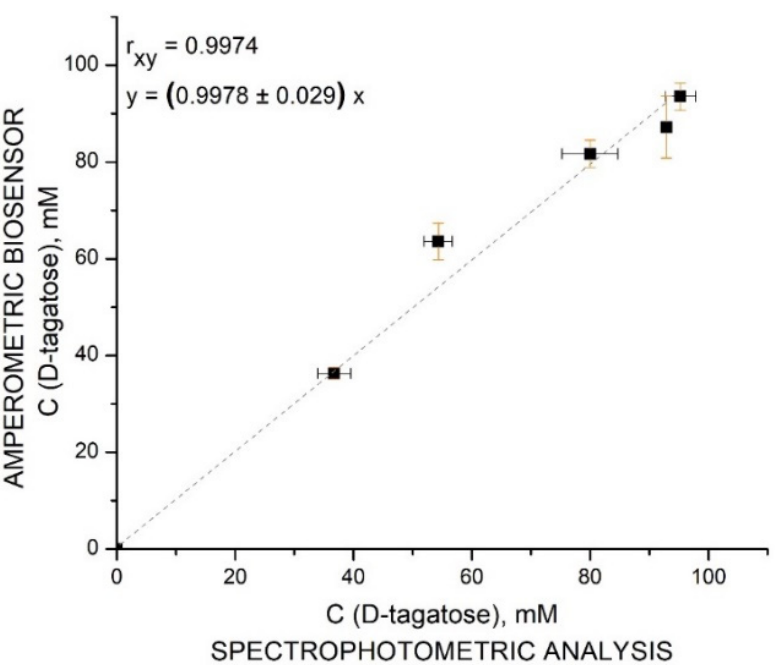
Figure 8. Correlation between the analysis of the formed D-tagatose using the TRGO/FDH biosensor